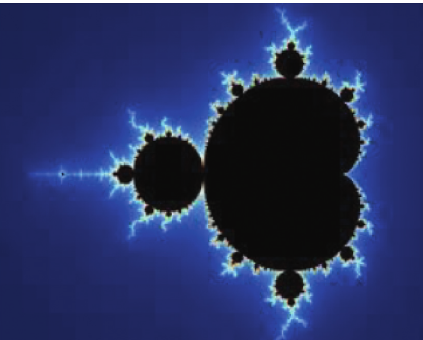
Figure 1: The Mandelbrot